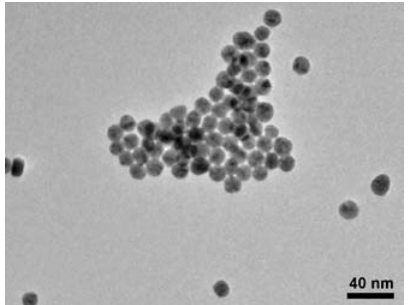
Figure 5. TEM image of colloidal gold nanoparticles used as additives in sensor architecture